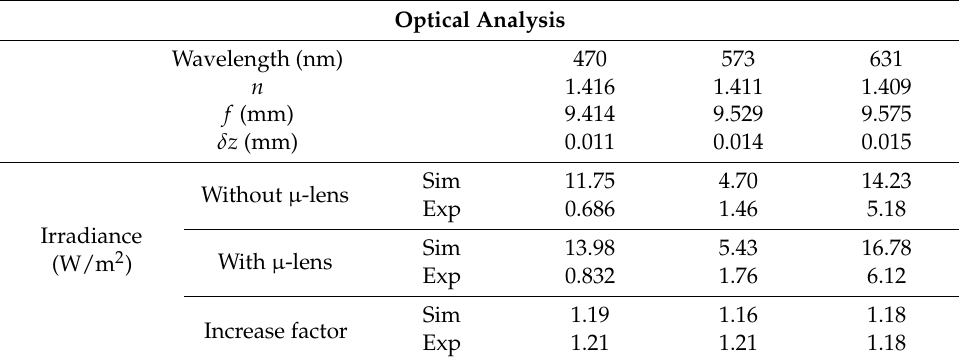
Table 3. Optical characterization and irradiance results of the ZEMAX ® optical simulation and experimental measurements for the blue, green, and red LEDs, with and without µ -lens. “Sim” are the simulation results and “Exp” are the experimental